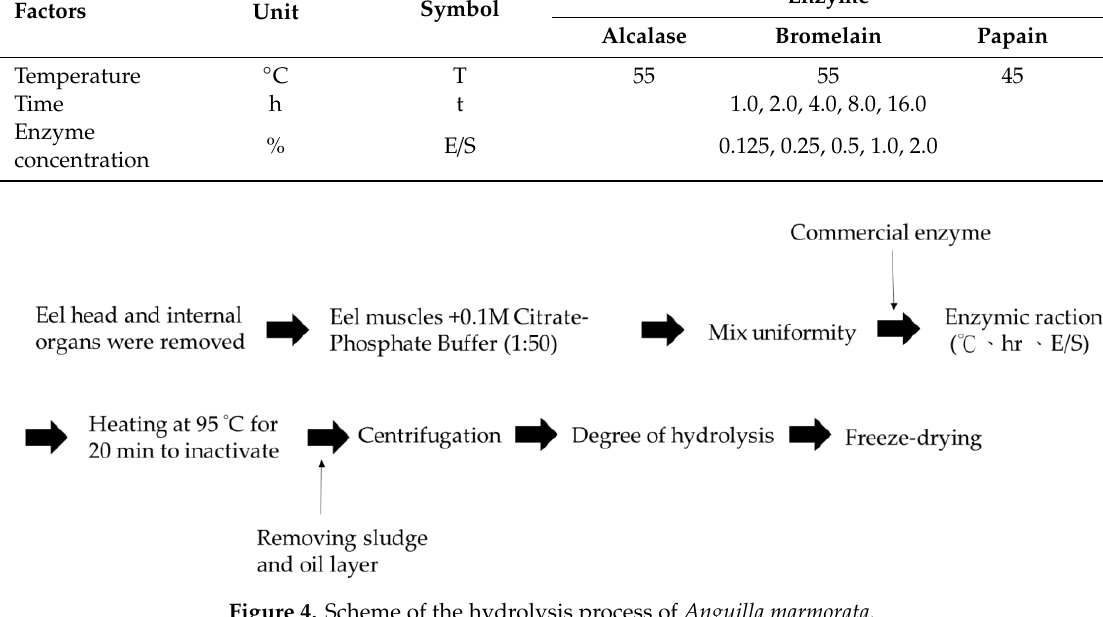
Table 5. Parameters used to obtain the optimal hydrolysis conditions for eel, using three different 257 enzymes 258